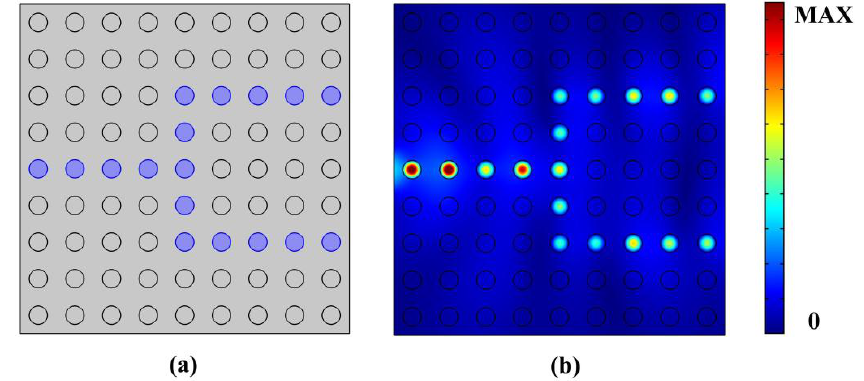
Figure 10. ( a ) Schematic of PhC beam splitter; ( b ) Normalized magnetic distribution of the PhC beam splitter with μ c1 = 0.6 eV, μ c2 = 0.9 eV, μ c3 =0.3 eV, operation frequency of 9.8e13 Hz.